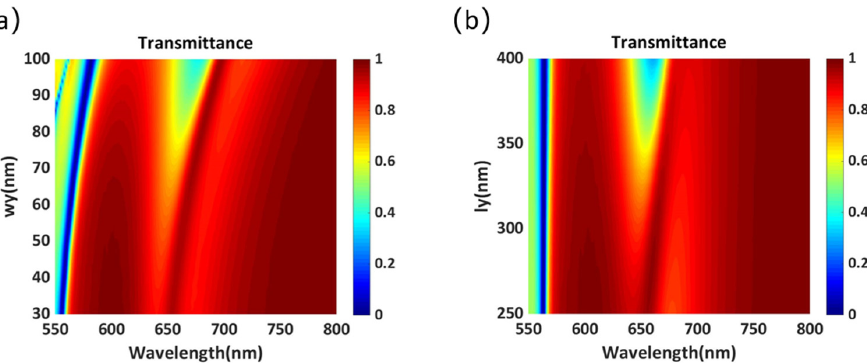
Figure 7. Transmittance of the proposed cross-shaped structure as a function of ( a ) w y and ( b ) l y